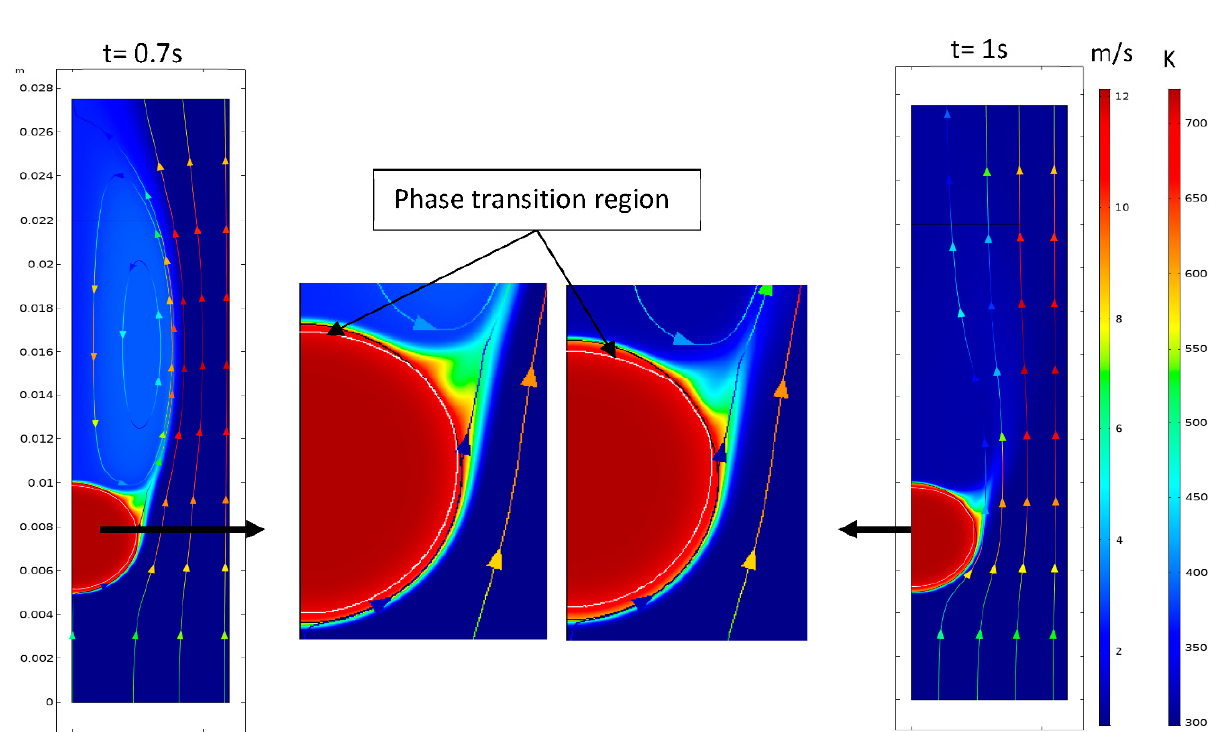
Figure 6. Temperature distribution of N 2 and the droplet (AgCl) domain with a droplet radius of 0.01 m.